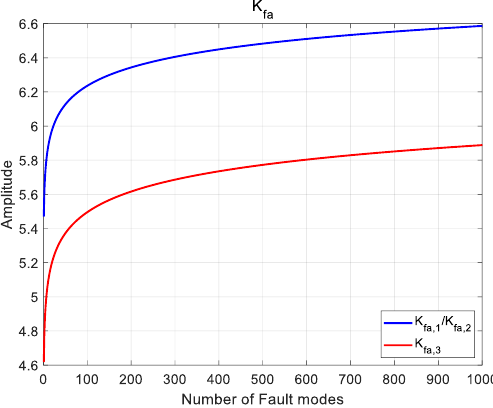
Figure 3. Relationship between K fa and number of fault